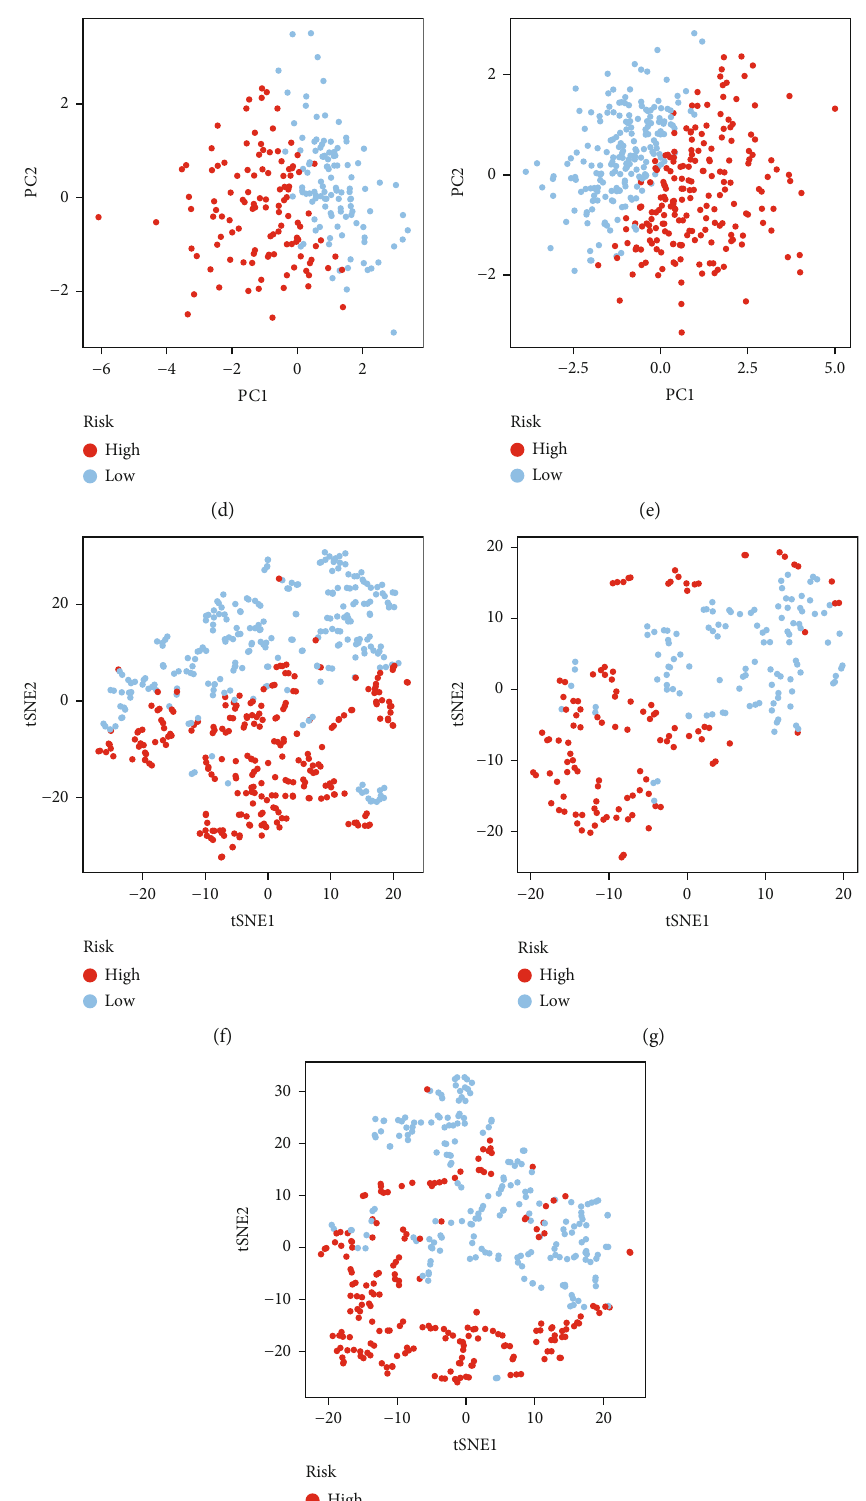
Figure 4: Performance analysis of the signature. (a) Univariate Cox regression analysis showing the independence of the signature. (b) Multivariate Cox regression analysis showing the independence of the signature. (c, f) TCGA-LUAD. (d, g) GSE31210. (e, h) GSE72094. (c – e) PCA analysis. (f – h) tSNE